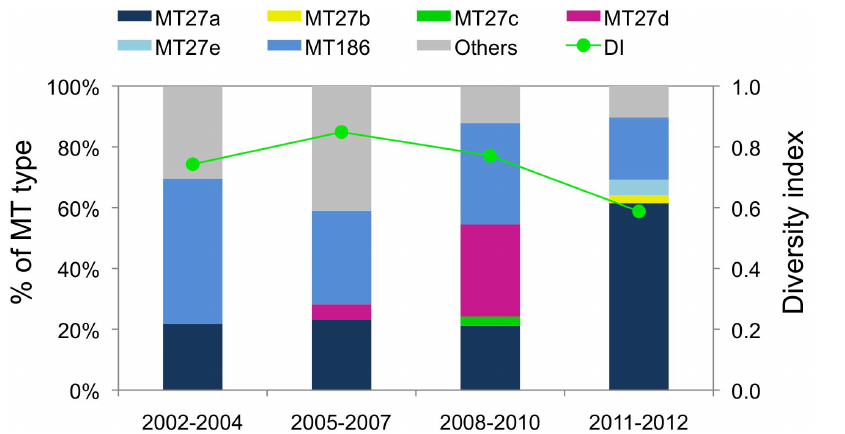
Figure 5. Frequency of MLVA types and genetic diversity of the Bordetellapertussis population in Japan from 2002 to 2012. The diversity index (DI) and 95% confidence interval (CI) were calculated from the MT frequencies within 4 time periods: 2002 2 2004 (non-epidemic), 2005 2 2007 (pre-epidemic), 2008 2 2010 (epidemic), and 2011 2 2012 (post-epidemic). For convenience, minor MTs (MT22, MT34, MT187, and MT248) are shown as ‘‘Others’’.